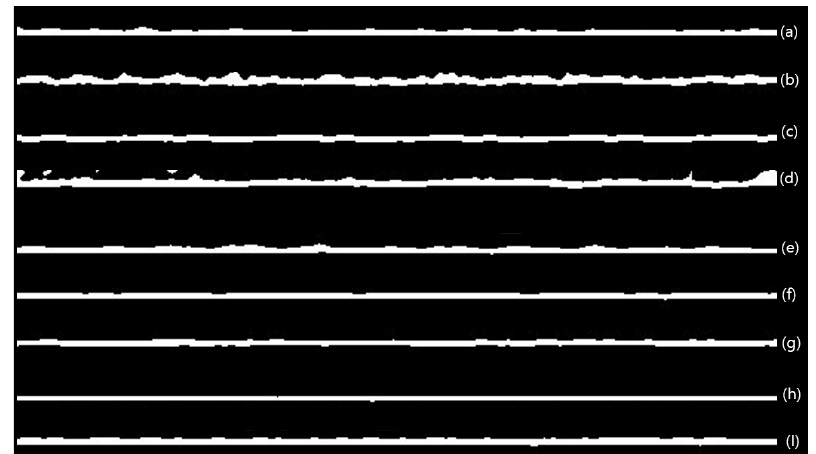
Figure 8. Images of the foulant layer by OCT (after thresholding). The white areas in the images represent the foulant layers. ( a ) Case 2—After 8 h (before shutdown). ( b ) Case 2—After shutdown, 16 h. ( c ) Case 2—Restart. ( d ) Case 2—After a 40 h operation time. ( e ) Case 3—After 8 h (before shutdown). ( f ) Case 3—After DI cleaning, 5 min. ( g ) Case 3—After shutdown, 16 h. ( h ) Case 3—Restart. ( i ) Case 3—After a 40 h operation time.